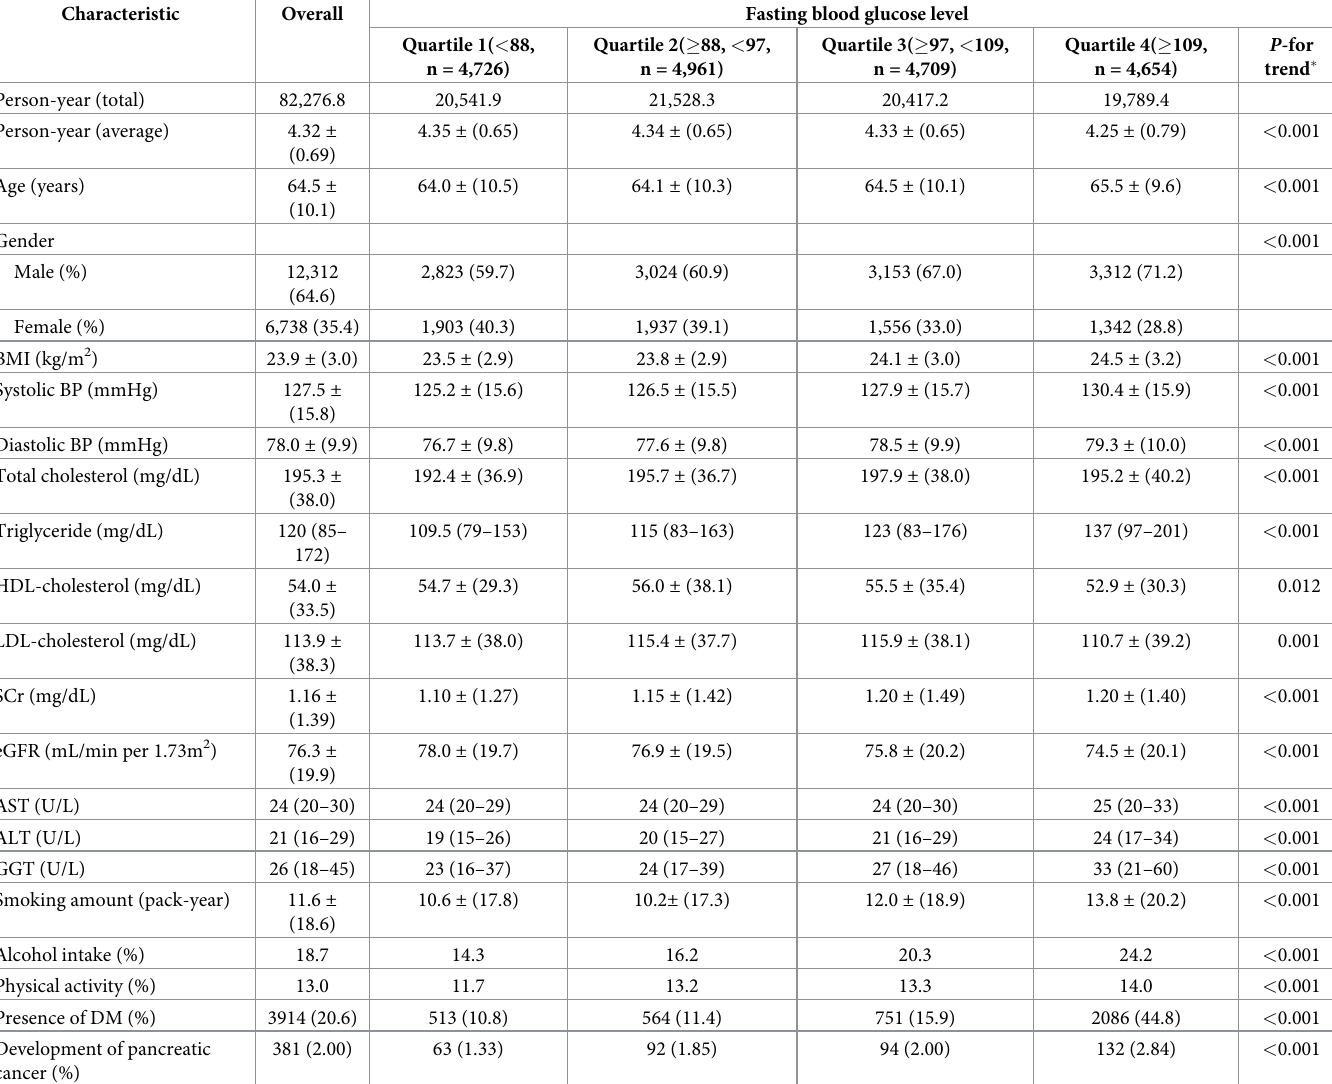
Table 1. Baseline characteristics of participants according to the quartile groups of fasting blood glucose levels (N = 19,050).